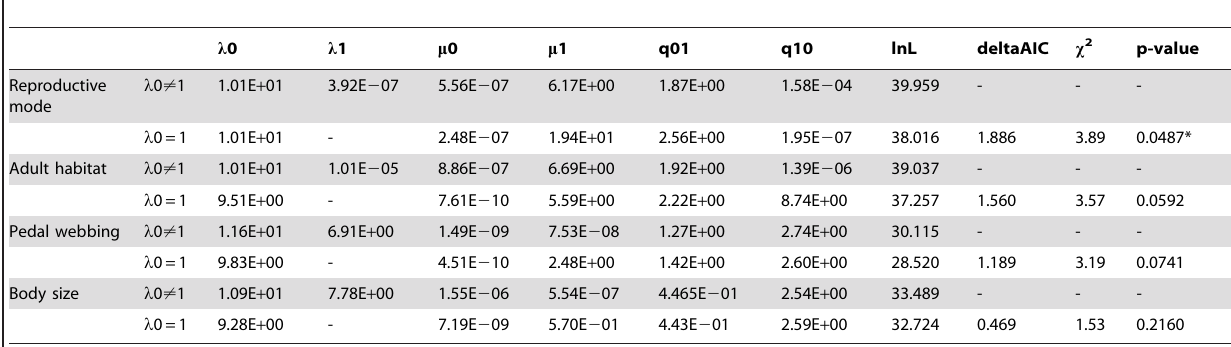
Table 1. Results of diversification analyses using the species tree generated from *BEAST and the discrete binary characters outlined below in BiSSE as implemented through